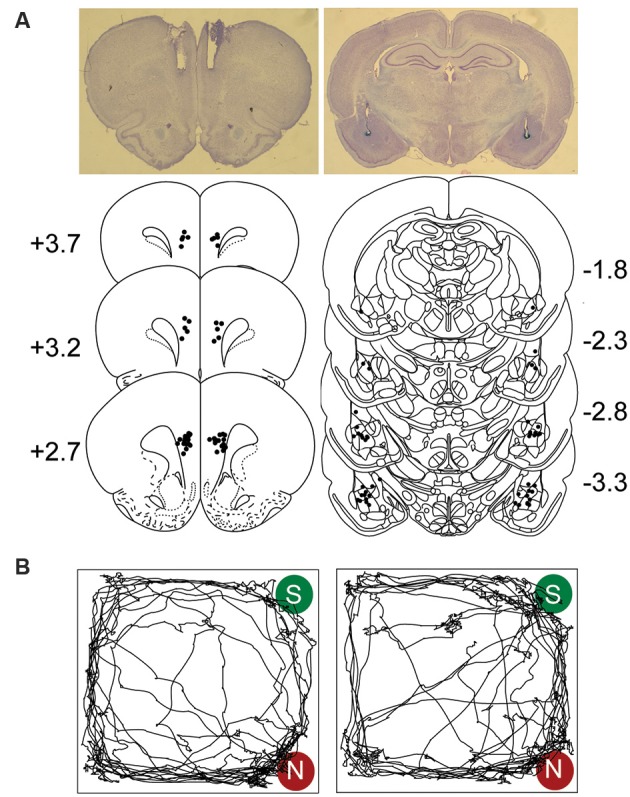
Electrodes and cannulae placements and track plots. (A) Photomicrograph and histological reconstruction of cannulae medial prefrontal cortex (mPFC, each dot represents the tips of the guide cannulae) and stimulating electrodes amygdala (BLA) implantations. (B) Representative visit maps from CTRL (left) and COMB treatments (right) during the sample (S) vs. novel (N) object test session. See text for object exploration criteria.